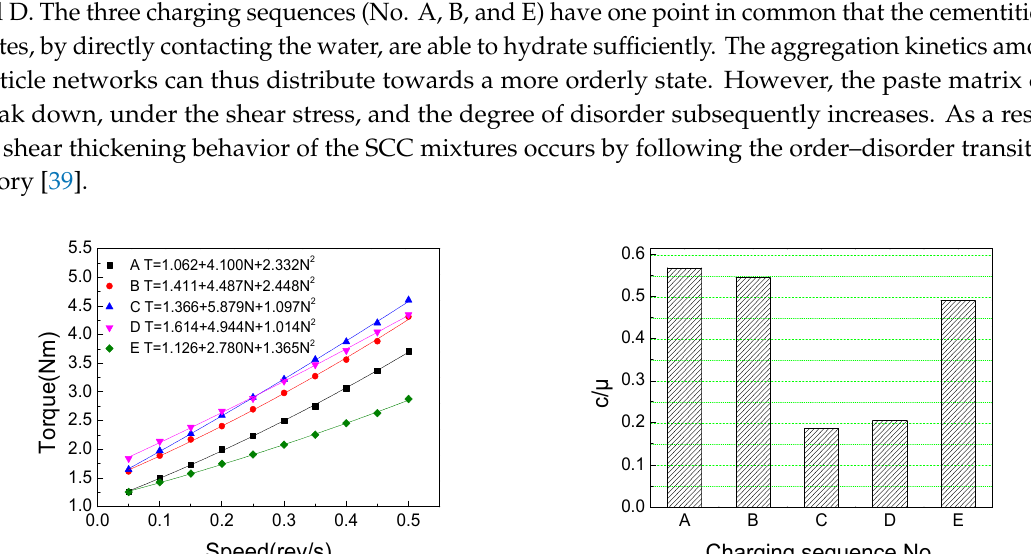
Figure 3. Relationship between the slump-flow and the yield stress of SCC.